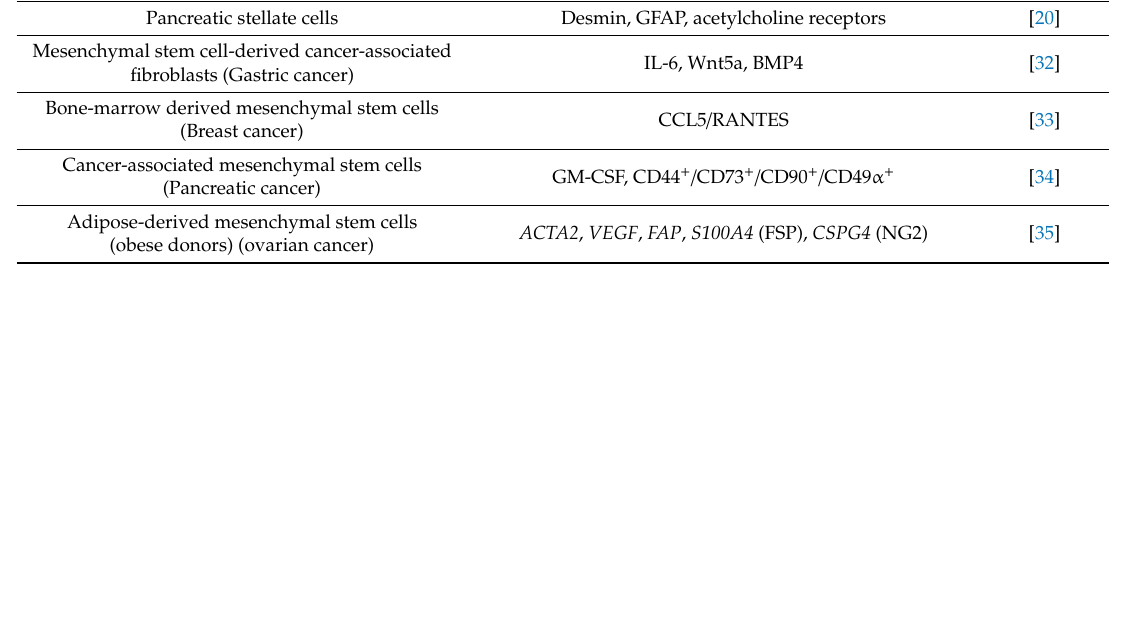
Table 1. Origin of cancer-associated fibroblasts (CAFs) and their markers.